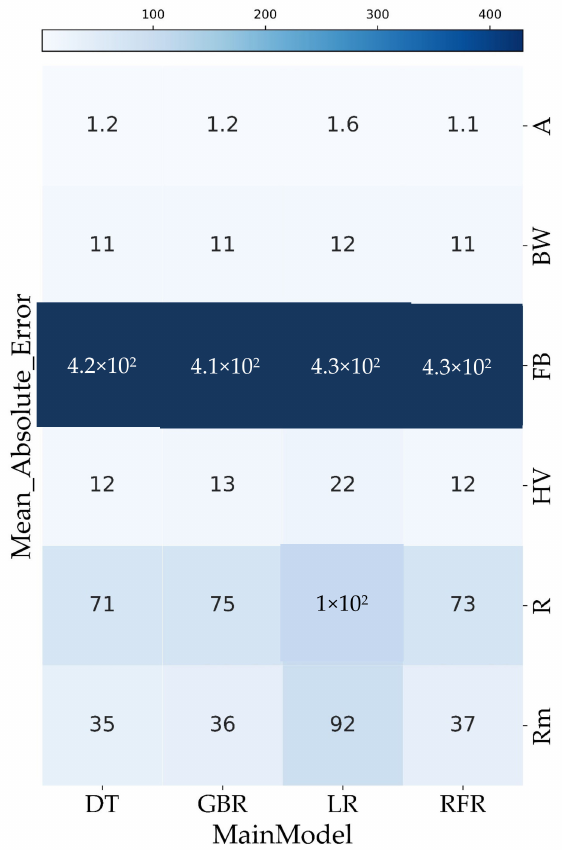
Figure 14. Heat map of the used ML methods in implementing the digital twins of the proposed alloy.